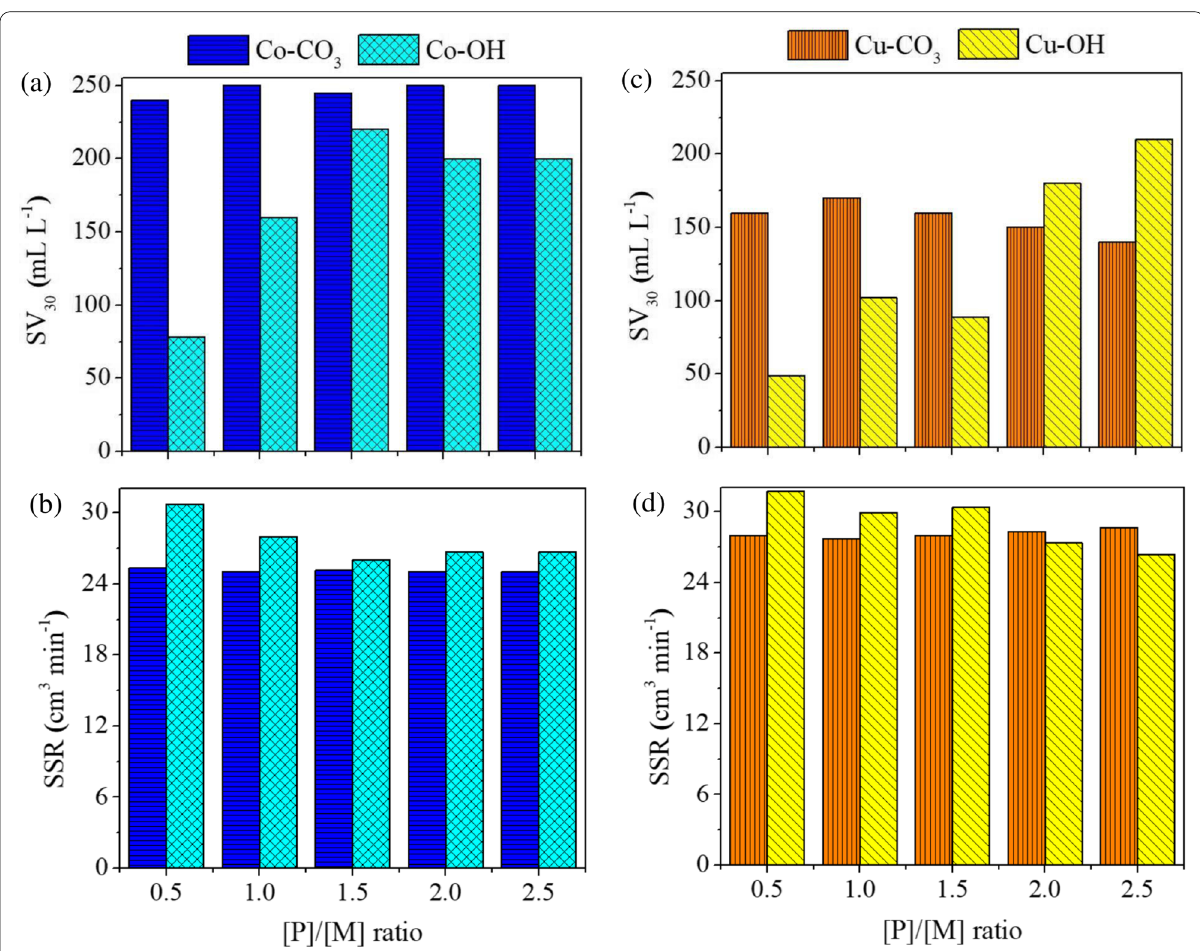
Fig. 10 Sludge volume at 30 min and sludge settling rate at different [P]/[M] ratio for cobalt ( a , b ) and copper ( c , d ) using different